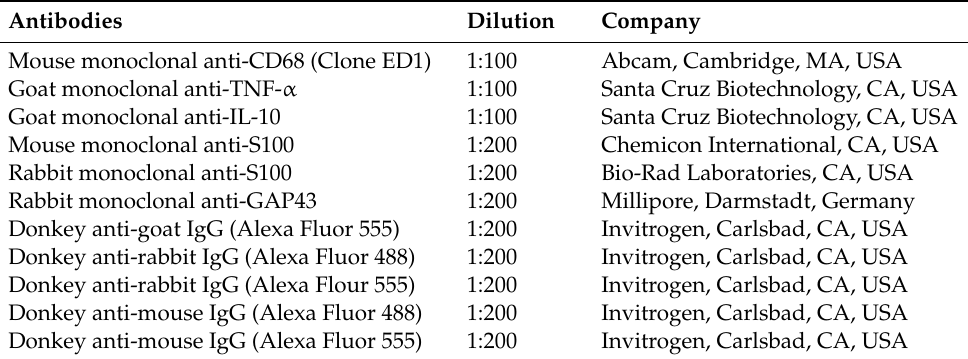
Table 1. List of primary and secondary antibodies used for immunofluorescence